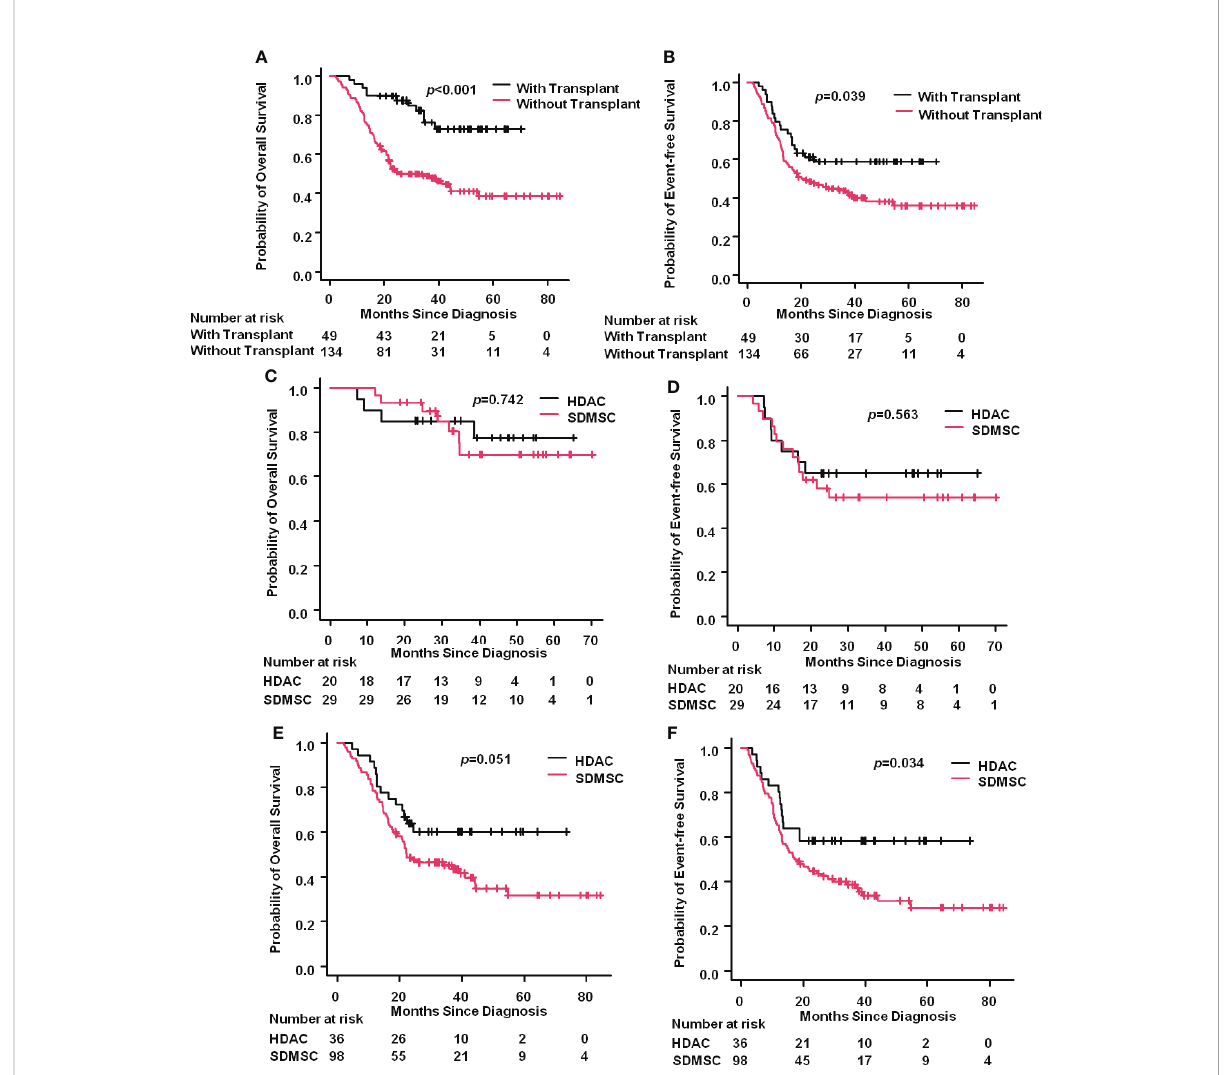
FIGURE 4 Impact of transplantation. The 3-year OS rate of AML patients with or without transplantation (A) . The 3-year EFS rate of AML patients with or without transplantation (B) . For the transplantation patients, the 3-year OS rate in the HDAC group and in the SDMSC group (C) , and the 3-year EFS rate in the HDAC group and in the SDMSC group (D) . For patients without transplantation, the 3-year OS rate in the HDAC group and in the SDMSC group (E) , and the 3-year EFS rate in the HDAC group and in the SDMSC group (F)